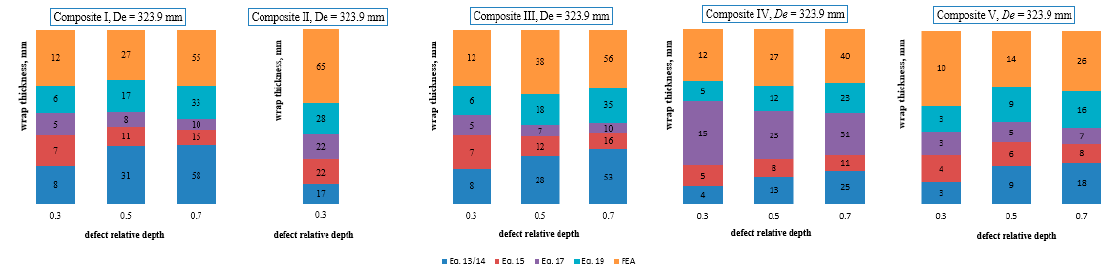
Figure 8. Summary of the results for case study no. 1 (from [21]).